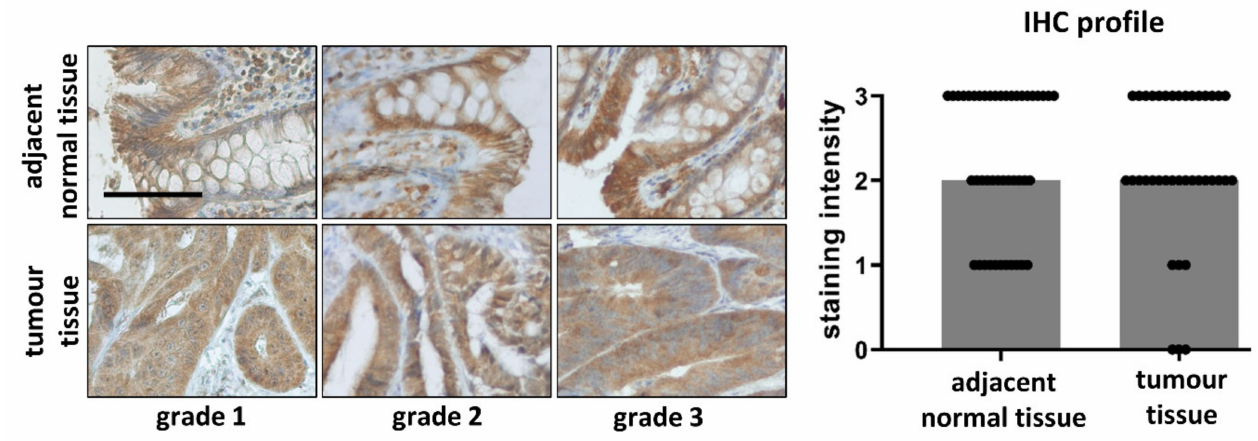
Figure 4. Expression of PPAR α in colorectal carcinoma and adjacent normal tissues. Representative microphotographs of grade 1, grade 2 and grade 3 tumours and adjacent normal tissue samples from the same patient. The immunohistochemical (IHC) profile is shown as the medians of staining intensities of all samples. Because there were no differences between tumours and adjacent normal tissues in grade 1, grade 2 and grade 3 tumours, all results for IHC staining are represented together ( n = 37). Columns represent medians of immunostaining intensities; each dot represents one patient. Magnification 100x; black line represents 100 µ m; brown - antibody signal; blue -